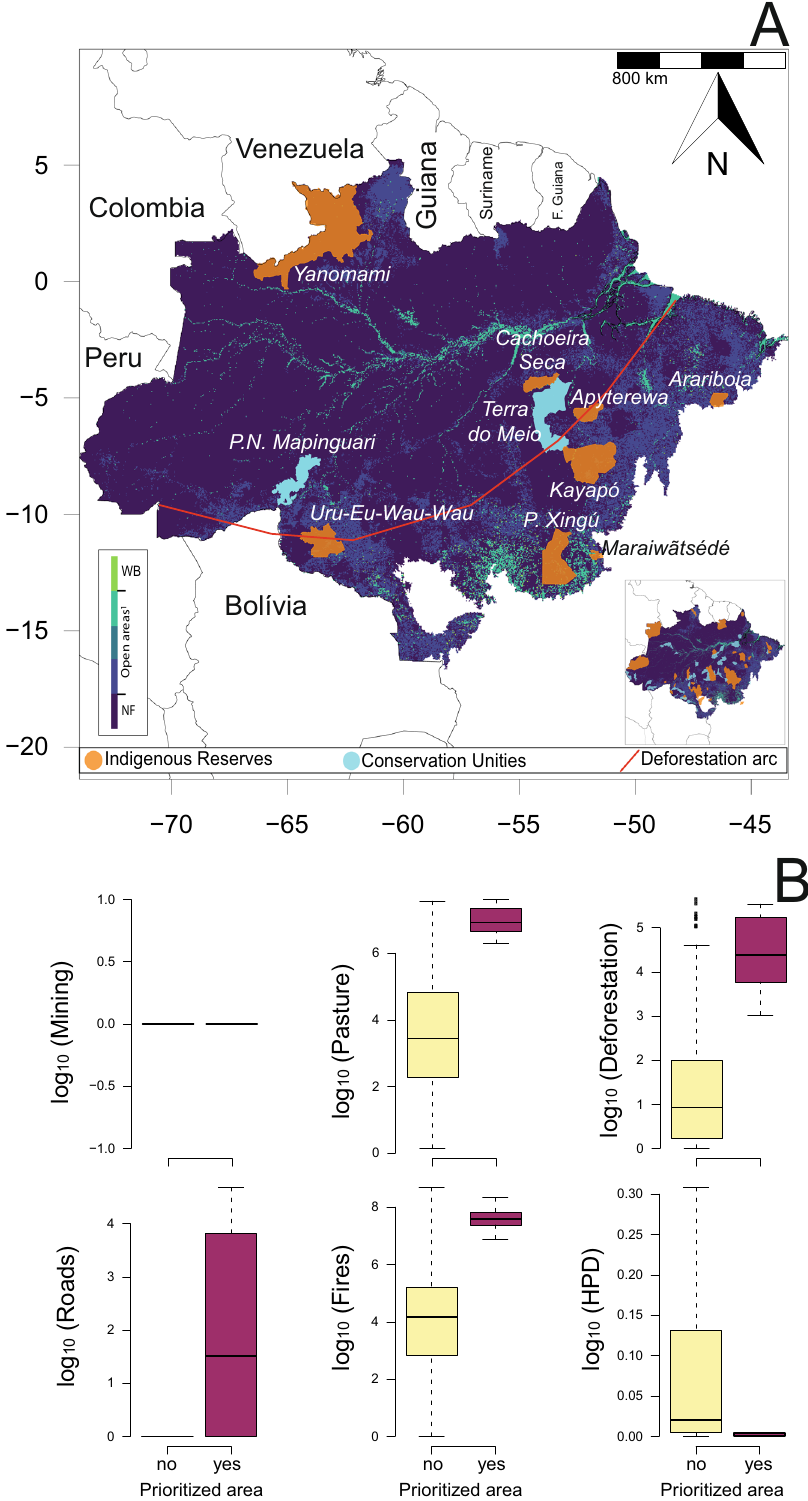
Fig. 4 Top-10 protected areas in the Brazilian Amazon prioritized for jaguar conservation. A Location of 10 protected areas in the Brazilian Amazon prioritized for jaguar conservation considering the threat index, jaguar density, and jaguar population size. The background map was produced by the authors and represents the land cover and land use dated from 2019 98 . WB water bodies, NF natural forest. 1 Open areas include non-forest natural vegetation, farming, and non-vegetation areas. For all land cover and land-use classes see ref. 98 . The small map bottom-right represent other 74 PAs that deserves prioritization (see Fig. 3C; Supplementary Data 3); B Mining (km 2 ); Pastures (km 2 ); Deforestation (km 2 ); Roads (km); Fire hotspots (N hotspots) and Human population density (HPD) comparison between areas that should be prioritized for jaguar conservation across the Brazilian Amazon. Data in ( B ) are log 10 -transformed and represents the data inside PAs. All elements in the fi gure were created by the authors using R